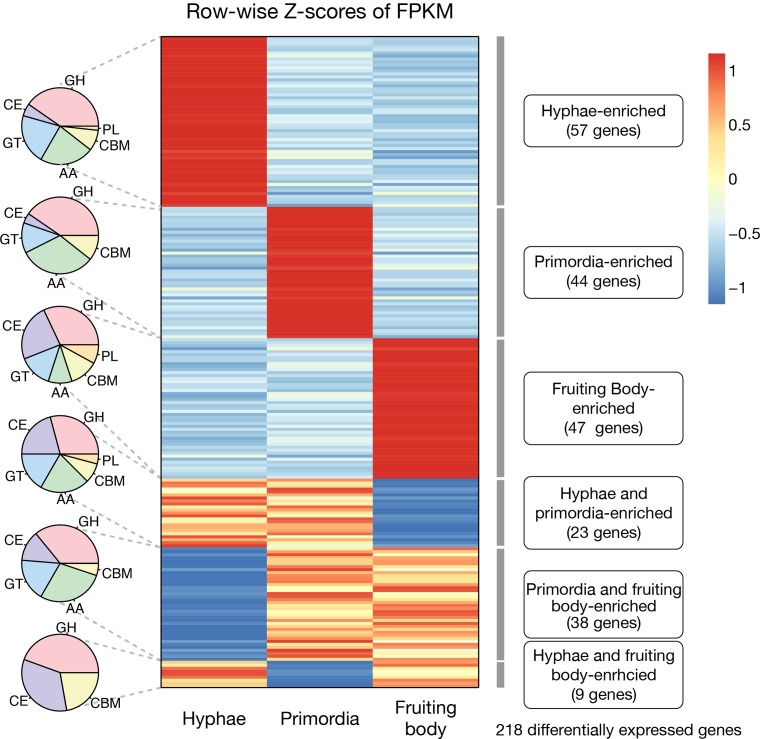
Differentially expressed CAZymes at each of the developmental stages.The pie graphs depict the number of CAZyme families for each specific expression type. Abbreviations for CAZyme families are as follows: glycoside hydrolase (GH), carbohydrate-binding module (CBM), glycosyl transferase (GT), polysaccharide lyase (PL), carbohydrate esterase (CE), and auxiliary activity (AA). Row-wise Z-scores of fragments per kilobase of transcript per million mapped reads were used.